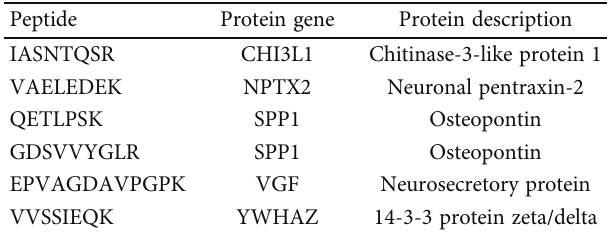
Table 1: The investigated peptides, their associated genes, and the protein